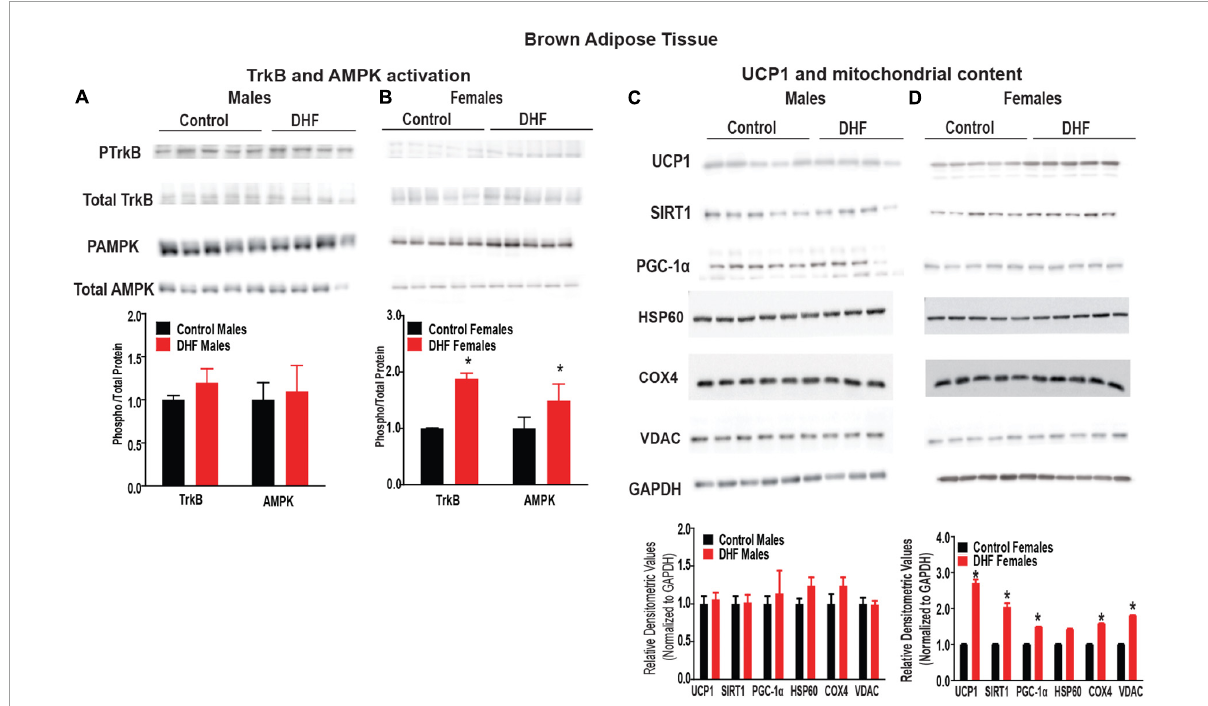
FIGURE4 DHF activates TrkB and UCP1 in BAT of females. (A,B) Expression and quantification of TrkB and AMPK activation in BAT. (C,D) Expression and quantification of mitochondrial content markers in brown adipose tissue (BAT). Statistical analyses were carried out using student’s t -test. p -values < 0.05 were considered significant. Data are expressed as average ± SEM ( n =